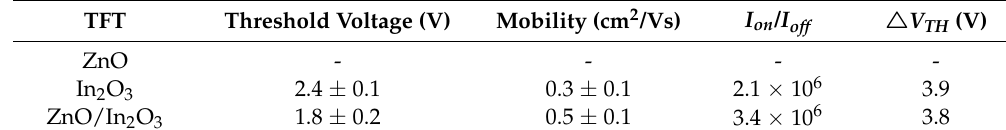
Table 1. Performance parameters of the fabricated TFTs.